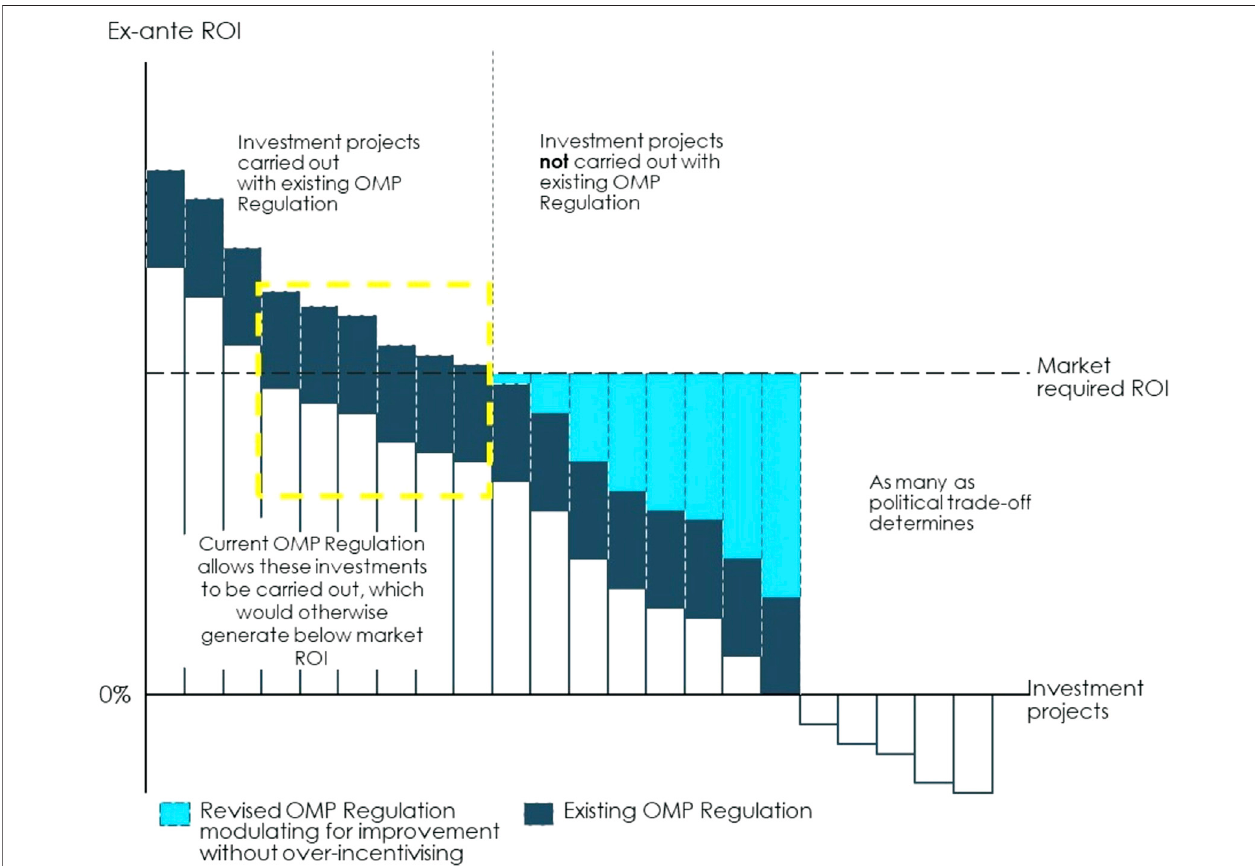
FIGURE 6 | Illustration of how modulated incentives can make OMPs fi nancially viable from an investor perspective. The current OMP Regulation aims to improve incentivesbyfosteringbasicresearch(funding),makingOMPdevelopmentlesscostlyandcomplex(feereductions,protocolassistance)andallowingforsalesrevenues withalowerriskofcompetition(marketexclusivity).Inthatway,thesetofincentivescurrentlyincludedintheOMPRegulationpairedwithawillingnesstopayforOMPsat the Member State level has increased the expected return on investment of OMP development projects, as illustrated by the dark blue bars. However, the lack of approved treatment for many rare diseases shows that there is still a need to strengthen incentives for investing in areas where rare disease patients ’ needs are